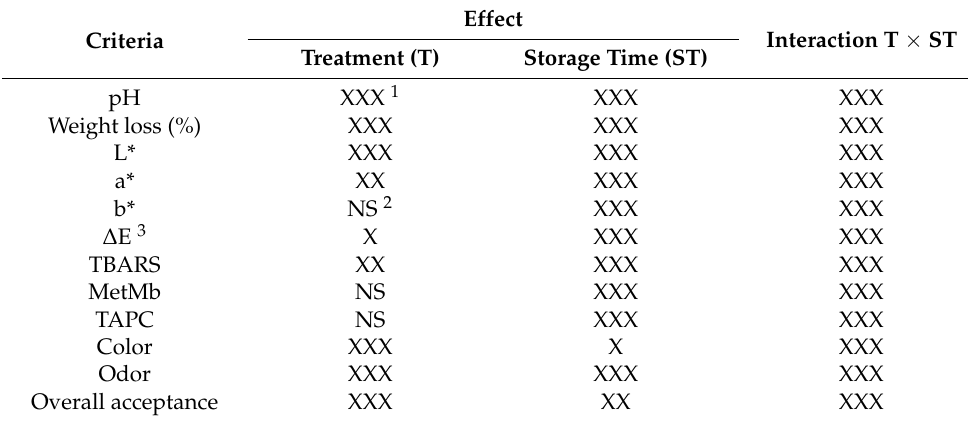
Table 1. Test probabilities for physicochemical, microbiological, and sensory criteria of the chicken meat samples generally and depending on storage time and the coating treatment—multi-aspect variance analysis including